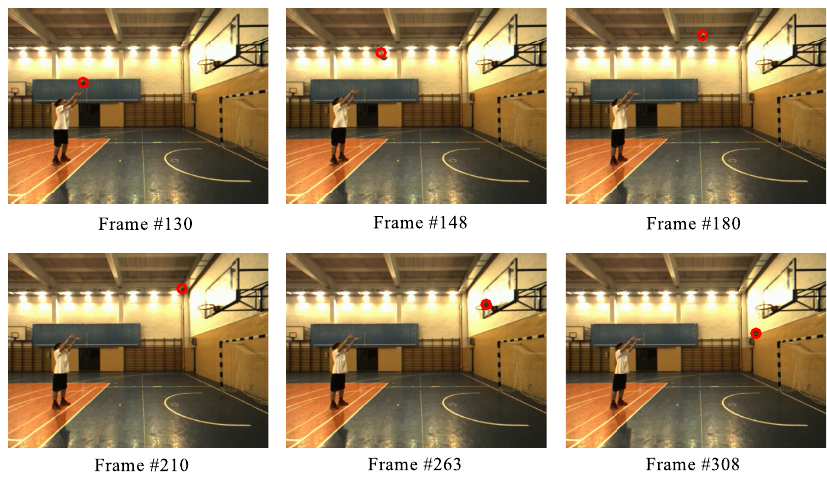
Figure 4. Ball tracking in selected frames of sequence s1.